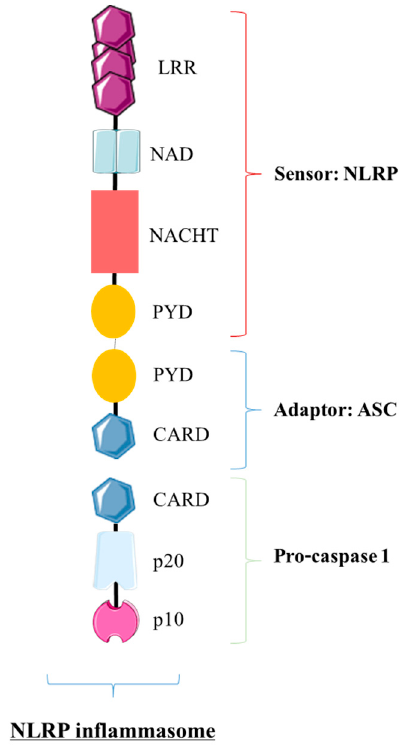
Figure 5. NLRP inflammasome structure. A NLRP inflammasome is composed of three major elements. First, there is a sensor, the receptor NLRP, which itself is generally composed of different domains: PYD (Pyrin domain), NACHT (acronym for NAIP, CIITA, HET-E, TP1), NAD (NACHT- associated domain) and LRR (Leucine-rich repeats). This LRR domain allows for an interaction with the adaptor ASC by the PYD domains. Then, ASC can recruit pro-caspase 1 thanks to the CARD (caspase recruitment domain) of each actor. In addition, pro-caspase 1 also contains a central p20 domain (including the catalytic site) and a p10 domain.